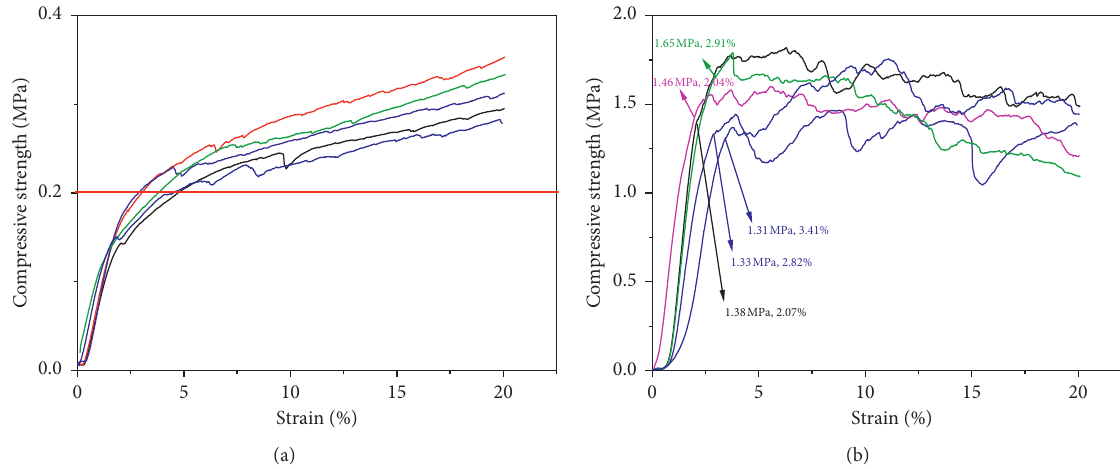
Figure 11: Compressive strength diagrams of carbon/carbon fiber composites: (a) front compression ( Z direction); (b) side compression ( X direction or Y